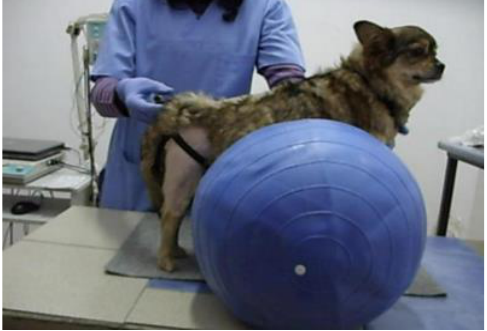
Figure 5. Changing the center of gravity forces the animal to adapt its center of gravity.